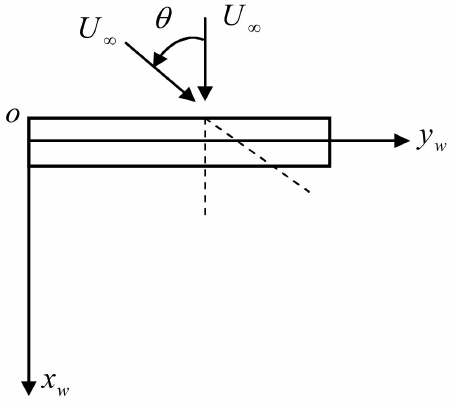
Figure 4. Rotation of the air